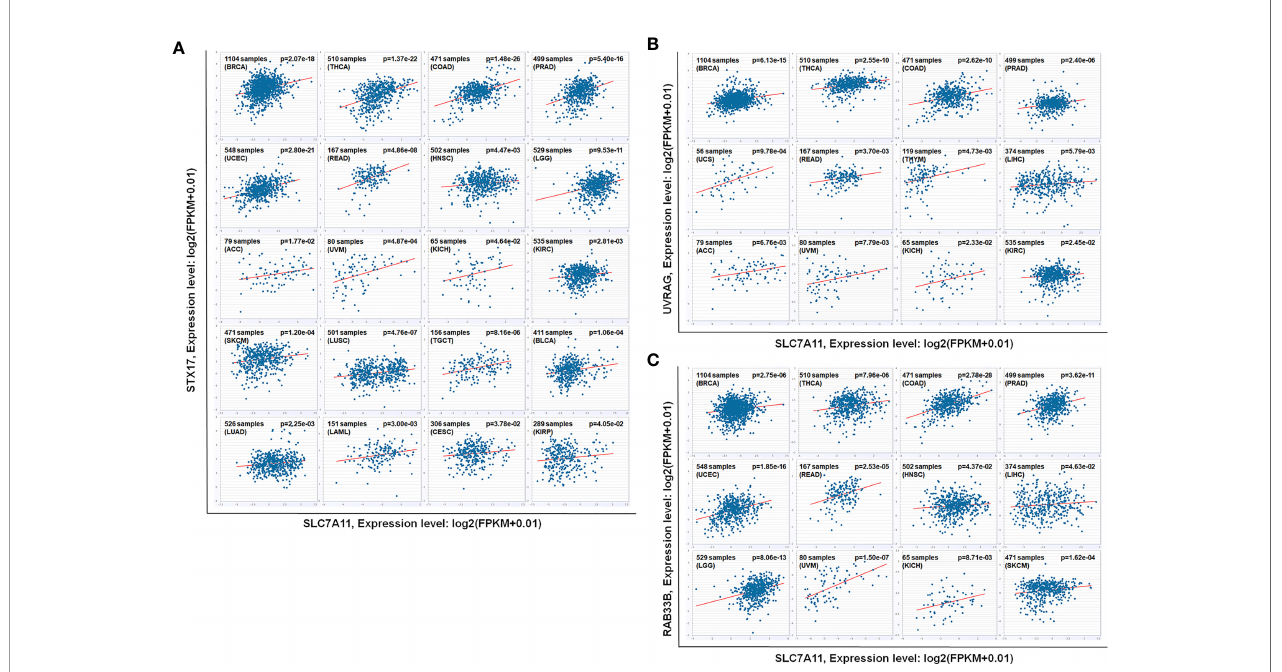
FIGURE 12 | As ceRNA targets of SLC7A11, (A) STX17, (B) UVRAG, and (C) RAB33B were positively co-expressed in 12, 20 and 12 kinds of cancers according to pan-cancer analyses. The other 2 cancers that SLC7A11 negatively co-expressed with RAB33B was excluded. The gene expression values from RNA-seq data were presented as log2 (FPKM + 0.01) ( P<0.05 ). BRCA, Breast Invasive Carcinoma; THCA, Thyroid Carcinoma; COAD, Colon Adenocarcinoma; PRAD, Prostate Adenocarcinoma; UCEC, Uterine Corpus Endometrial Carcinoma; READ, Rectum Adenocarcinoma; HNSC, Head and Neck Squamous Cell Carcinoma; LGG, Brain Lower Grade Glioma; ACC, Adrenocortical Carcinoma; UVM, Uveal Melanoma; KICH, Kidney Chromophobe; KIRC, Kidney Renal Clear Cell Carcinoma; SKCM, Skin Cutaneous Melanoma; LUSC, Lung Squamous Cell Carcinoma; TGCT, Testicular Germ Cell Tumors; BLCA, Bladder Urothelial Carcinoma; LUAD, Lung Adenocarcinoma; LAML, Acute Myeloid Leukemia; CESC, Cervical Squamous Cell Carcinoma and Endocervical Adenocarcinoma; KIRP, Kidney Renal Papillary Cell Carcinoma; UCS, Uterine Carcinosarcoma; THYM, Thymoma; LIHC, Liver Hepatocellular